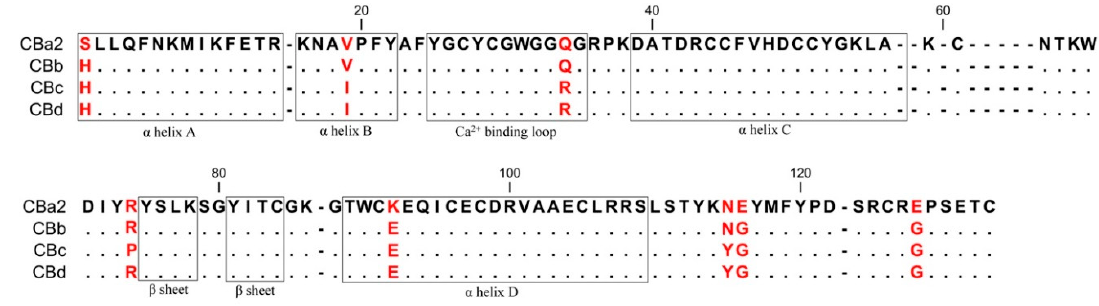
Figure 2. Alignment of amino acid sequences of the four natural CB isoforms. Distinguishing residues of the isoforms are indicated in red. Sequences are from the GenBank/NCBI database: CBa 2 (P24027.1), CBb (P0CG56.1), CBc (P62022.1) and the sequence of CBd from this study. Residues are numbered according to Renetseder et al. [26].